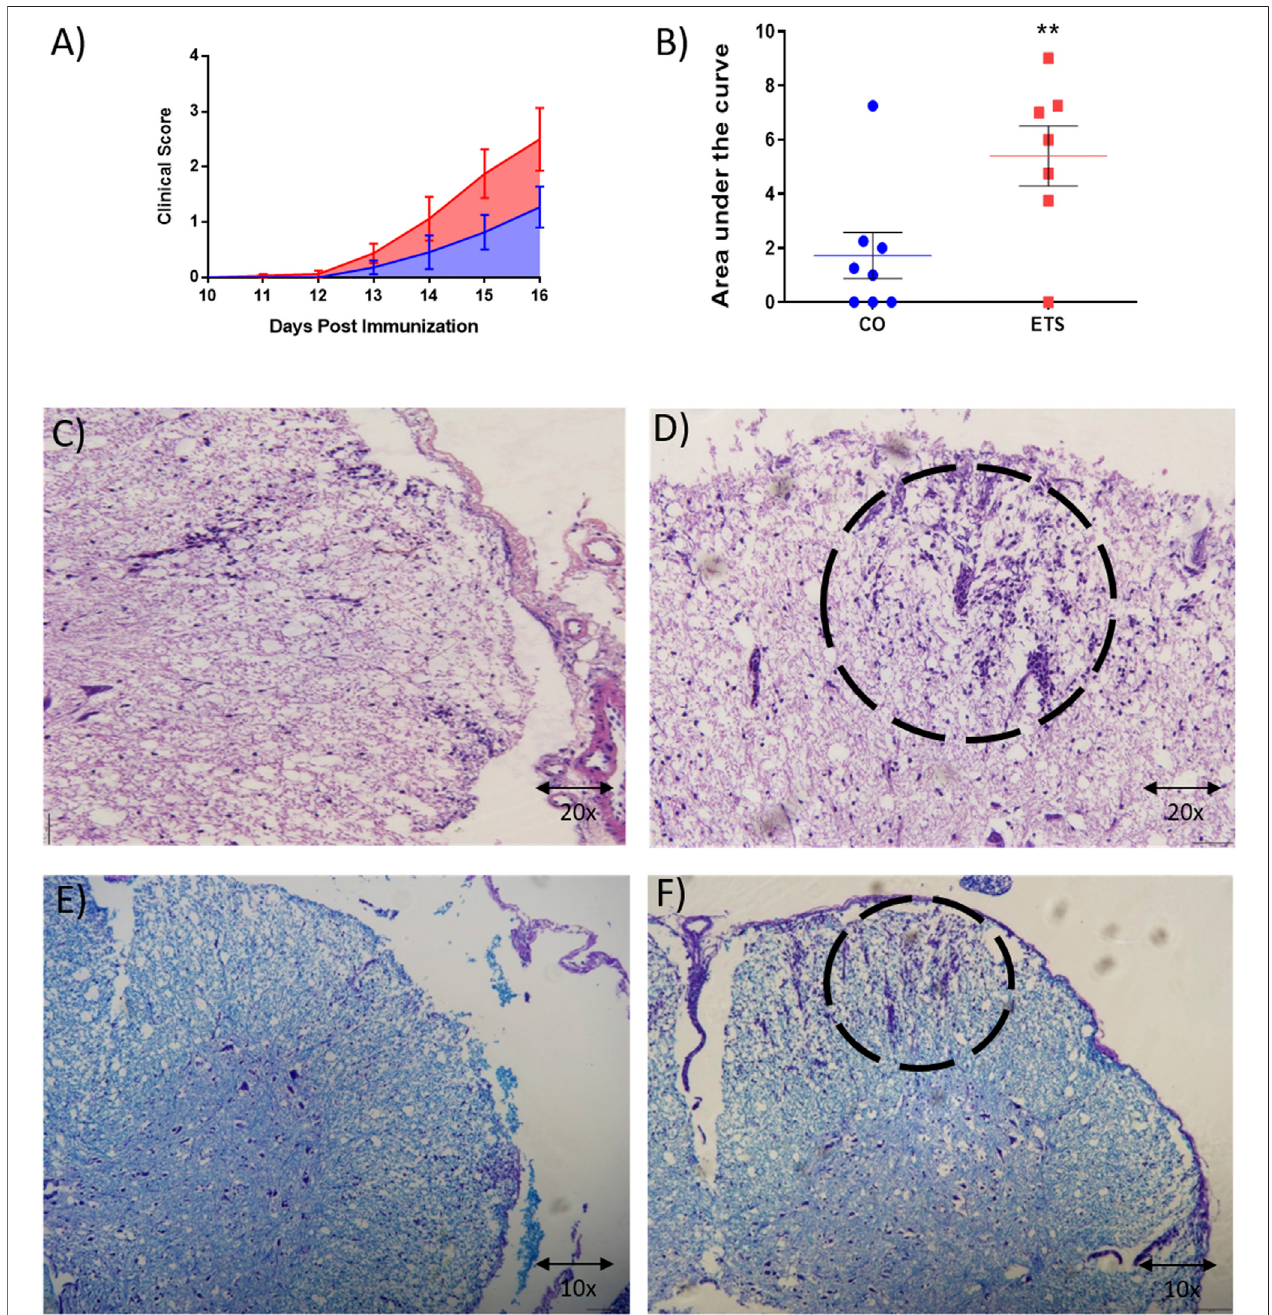
FIGURE5| EAE clinicalscore in animals exposedor not toenvironmental tobaccosmoke (A) Curve upto thepeak (15th day); (B) Area under thecurve.Statistical analysis: Student ’ s t-test * p < 0.05, ** p < 0.01, *** p < 0.0001 n (cid:1) 12; (C – F) Hematoxylin & Eosin or Luxol Fast Blue staining n (cid:1) 3 (C,E) represents control groups and (D,F) exposed groups. Marrow cut in the distal third. Data are expressed as mean ± SEM.